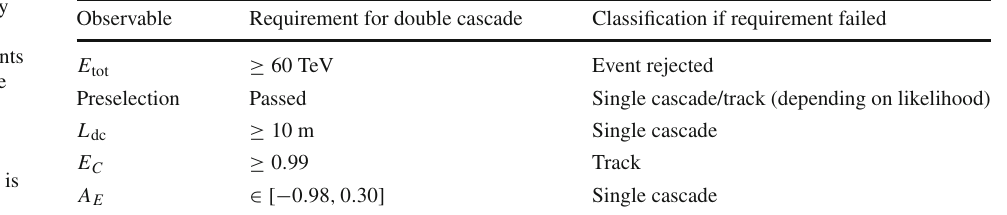
Table 1 Steps for the ternary Observable Requirement for double cascade Classification if requirement failed topological classification in order of precedence. For events E tot ≥ 60 TeV Event rejected failing the “preselection”, the Preselection Passed Single cascade/track (depending on likelihood) likelihoods of the track and L dc ≥ 10 m Single cascade single-cascade fits are compared, and the topology E C ≥ 0 . 99 Track with the higher likelihood fit is A E ∈ [− 0 . 98 , 0 . 30 ] Single chosen